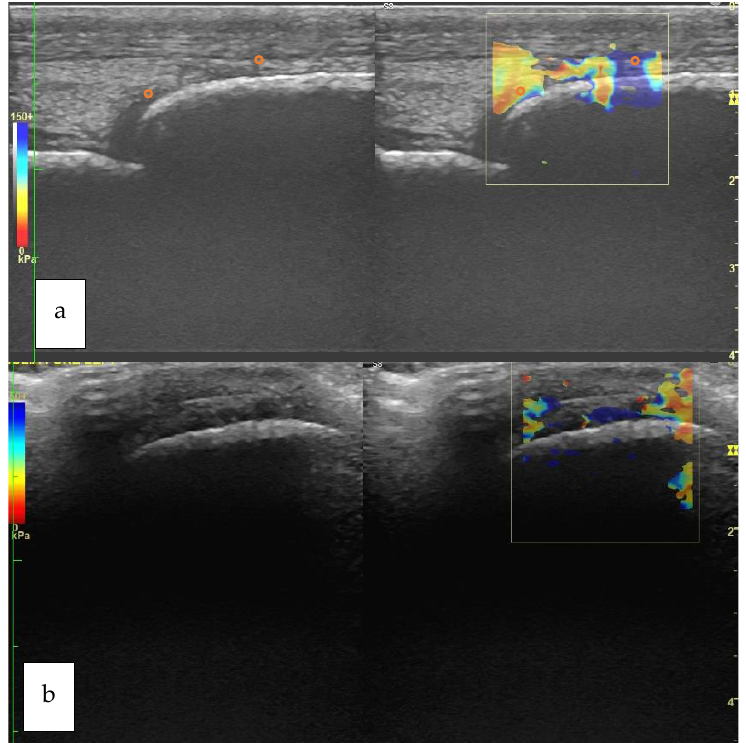
Figure 3. Longitudinal ( a ) and transverse ( b ) view of the metacarpophalangeal joint of a horse belonging to Group H. The orange circle that is superimposed to the elastogram shows the positioning of the ROI. The B-mode corresponding to each elastogram is shown on the left of each box (Group H: horses not affected by osteoarthritis; ROI: Region of Interest).